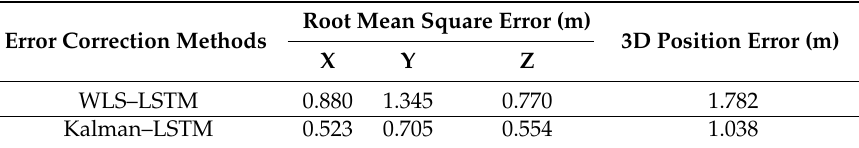
Table 5. Positioning errors of error correction methods.